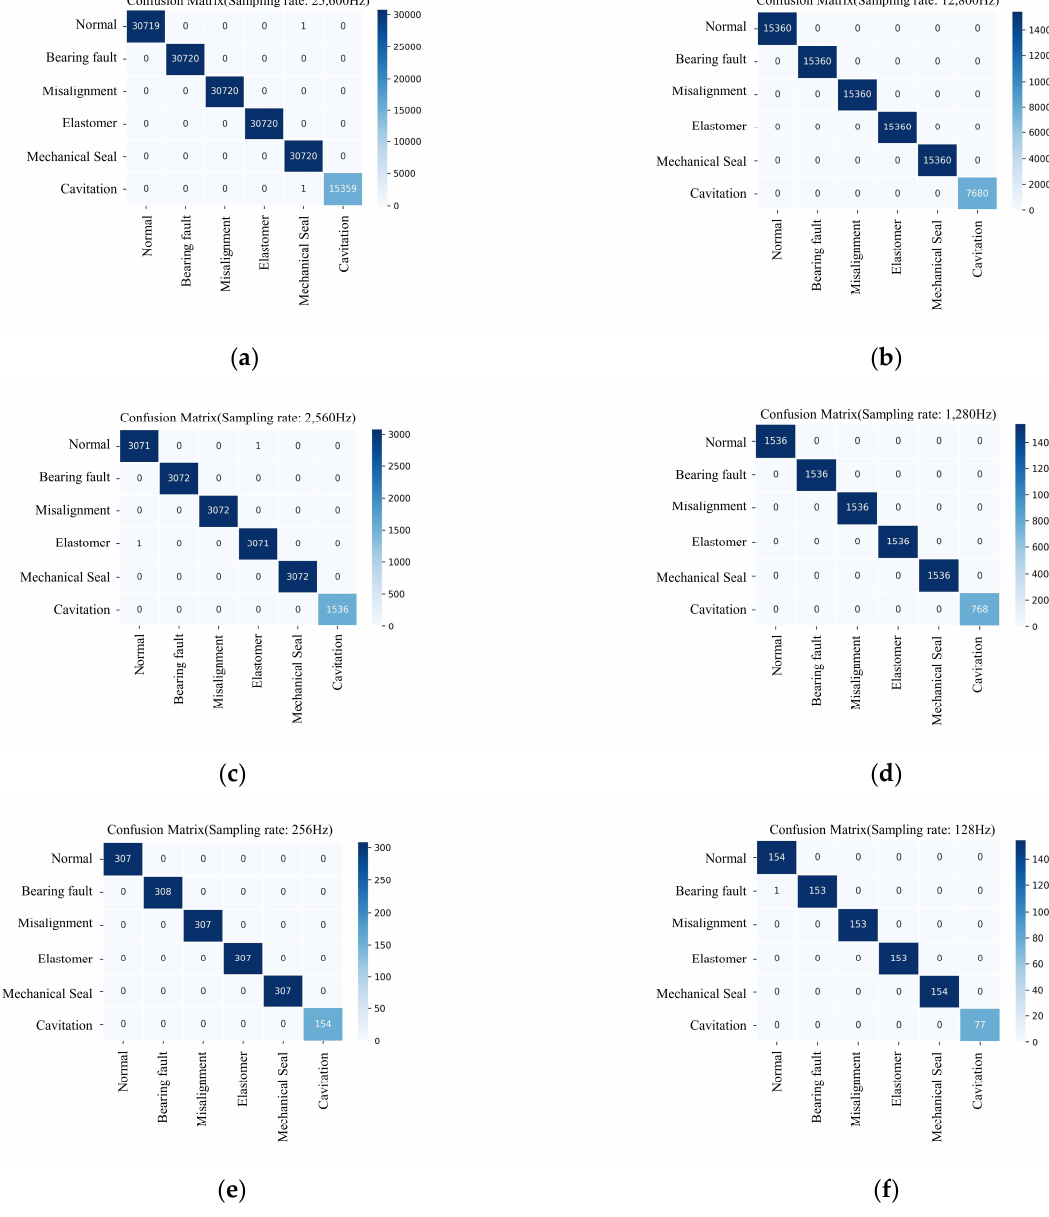
Figure 7. Multi-class confusion matrix as the results of the fault classification by sampling rate: ( a ) 25,600 Hz; ( b ) 12,800 Hz; ( c ) 2560 Hz; ( d ) 1280 Hz; ( e ) 256 Hz; and ( f ) 128